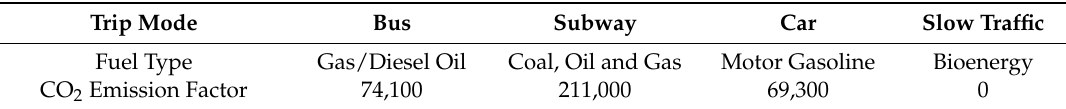
Table 3. Transportation default CO 2 emission factor for different trip modes (kgCO 2